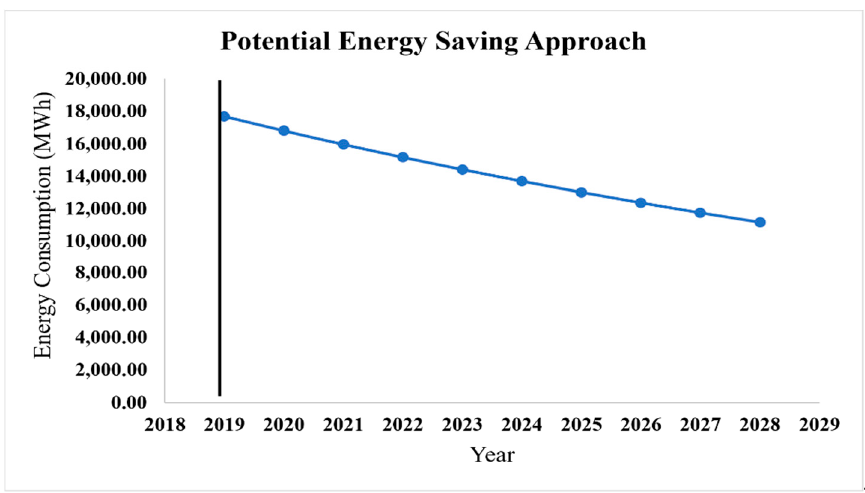
Figure 9. Potential groundwater saving approach in 2019.